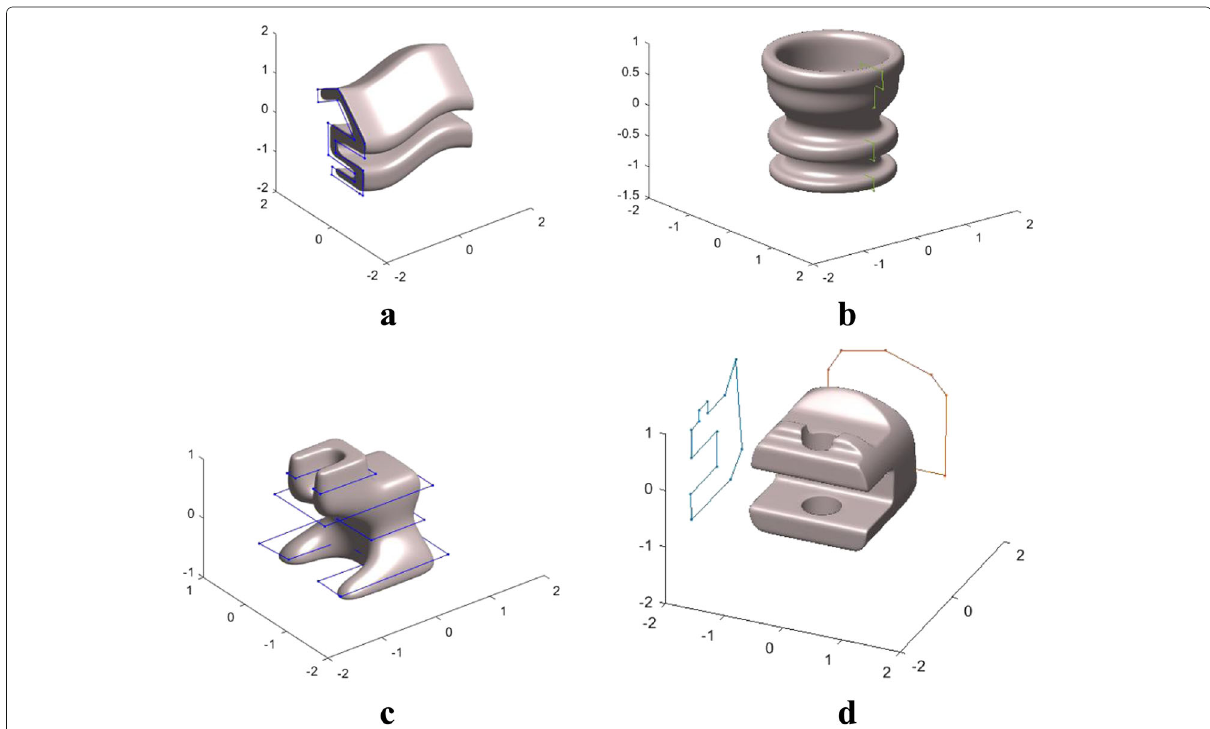
Fig. 8 3D implicit object design using the 2D implicit functions: a . Implicit geometric object of extrusion. b . Implicit geometric object of revolution. c . Implicit geometric object design based on a stack of parallel 2D implicit slices defined by bivariate functions. d . Implicit geometric object design based on silhouette